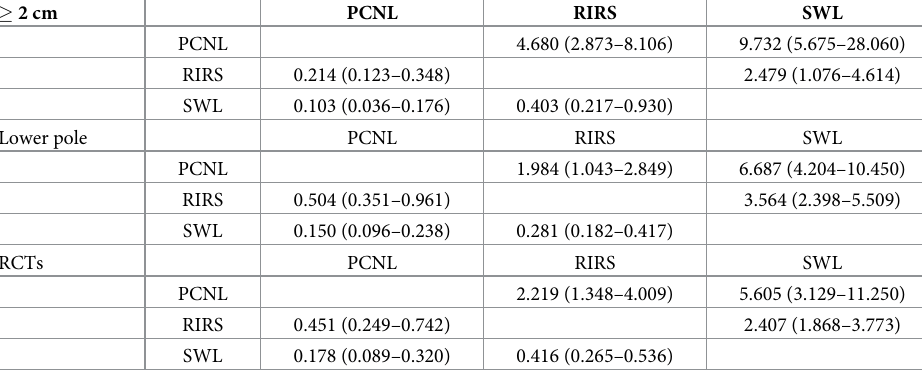
Table 2. Subgroup network meta-analysis for � 2 cm stone, lower pole stones and RCTs. PCNL, percutaneous nephrolithotomy; SWL, shock wave lithotripsy; RIRS, retrograde intrarenal surgery. � 2 cm